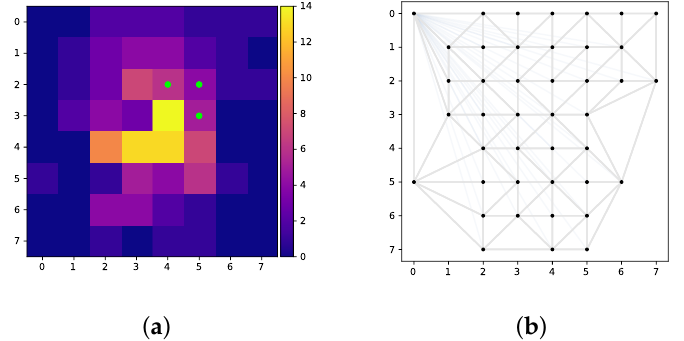
Figure 2. Illustrations of a small map instance. Each tile of the map is 0.5 × 0.5 km. ( a ) Score map. ( b ) Graph